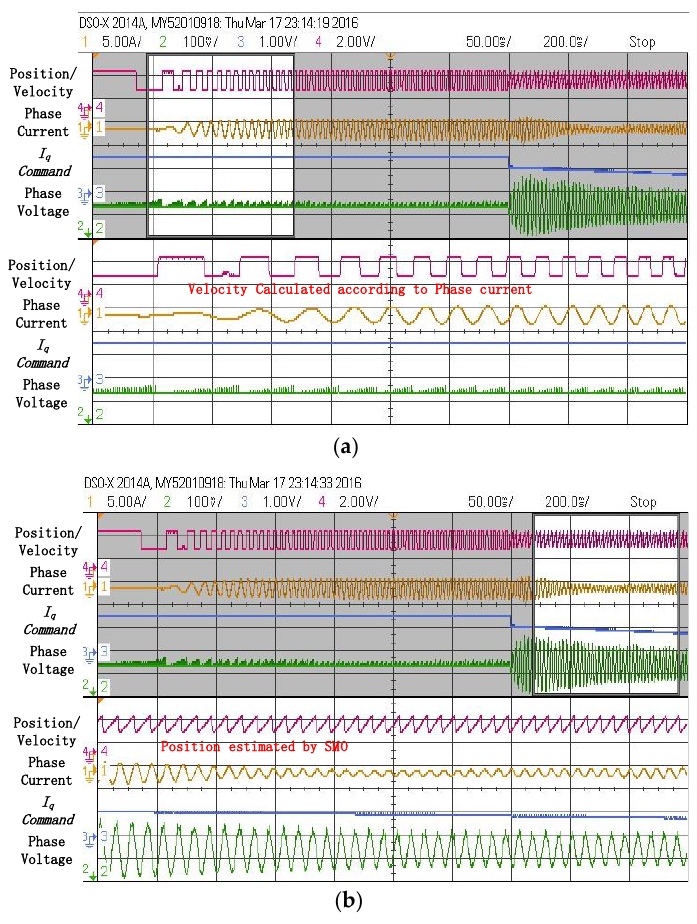
Figure 12. Starting process of the generation system. ( a ) When shaft speed is below the threshold; ( b ) When speed goes up through the threshold.